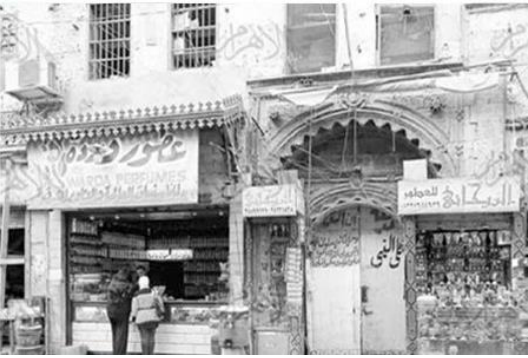
Figure 3. The façade of Wikāliẗ ạl-’Anbariyin. (Source: Al-Ahram online article, 2016 http://www.ahram.org.eg/NewsQ/565296.aspx)